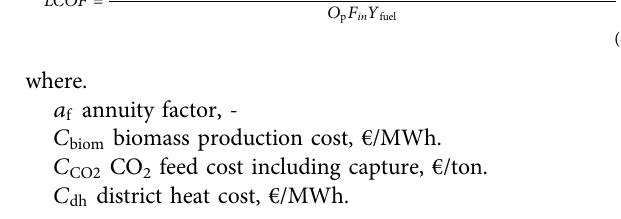
Frontiers in Energy Research |